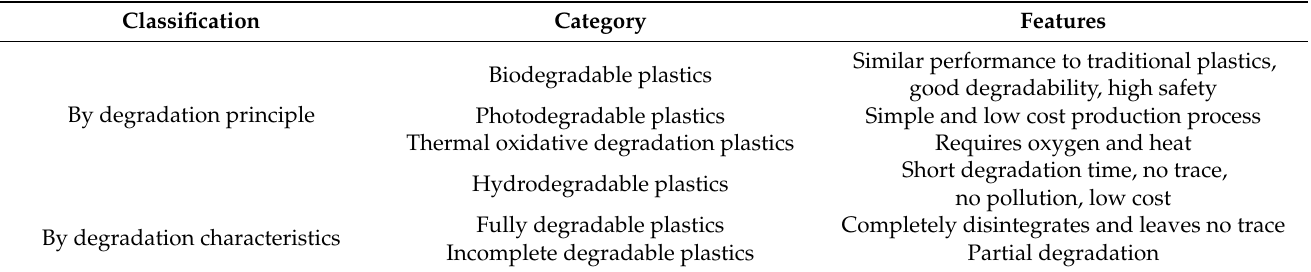
Table 1. The classification and characteristic of degradable plastics.